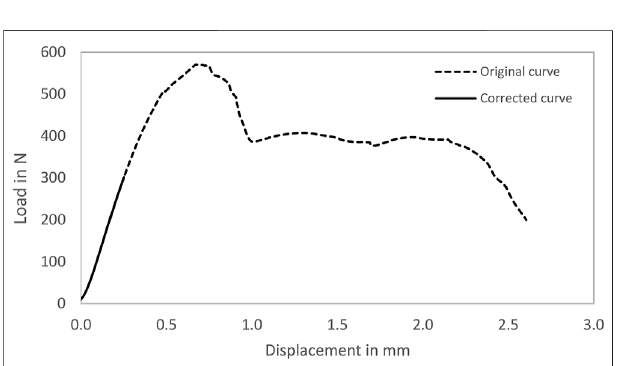
FIGURE 2 | Exemplary original (dotted line) and corrected load- displacement curve (continuous line;onsetofnon-linearbehaviour)ofaSENB test specimen (30% Danu fi l 3.3